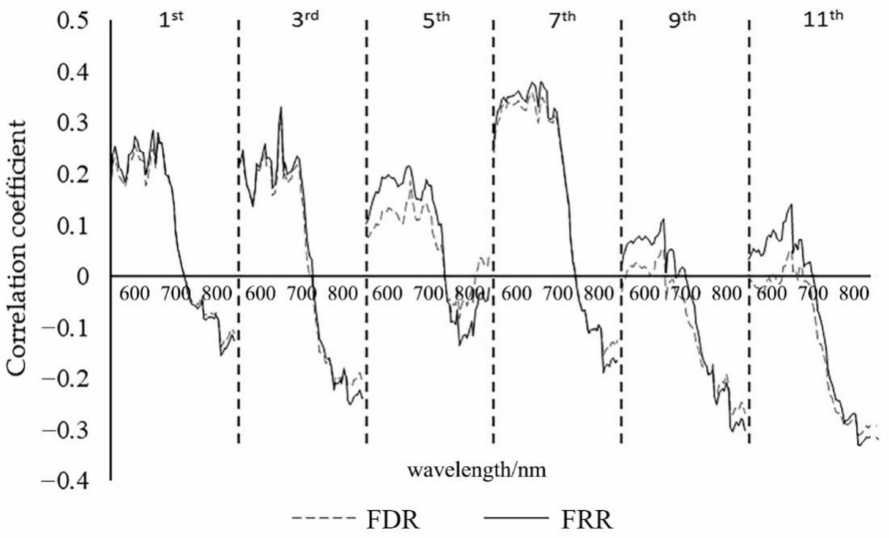
Figure 4. Correlation between rice yield and the difference florescence reflectance (FDR), the rice yield and the ratio florescence reflectance